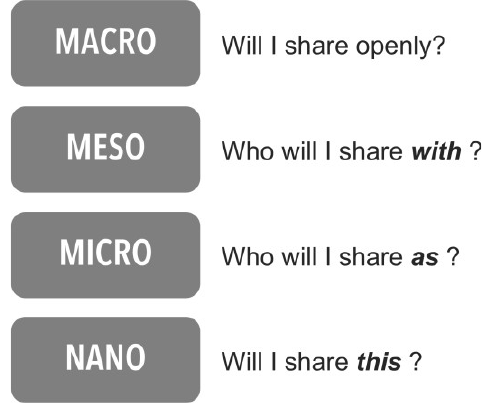
Figure 2 . Considering openness at four